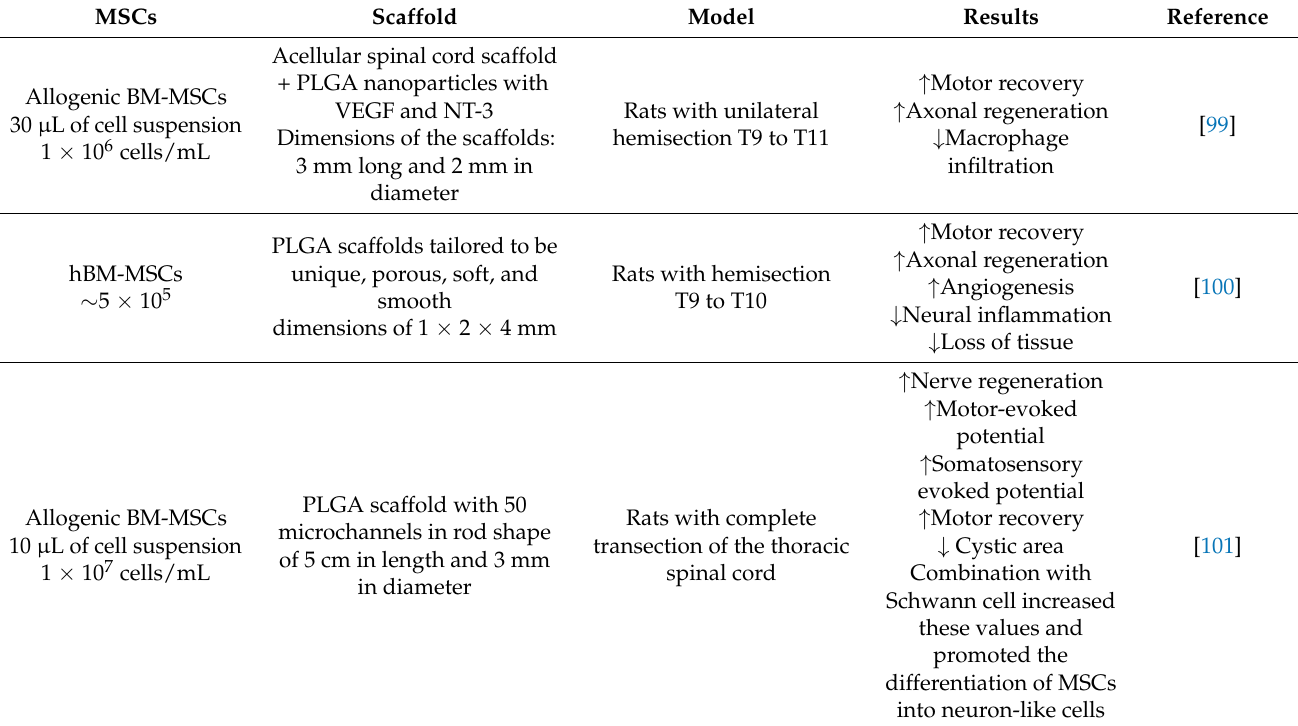
Table 4. Overview of the studies evaluating biochemical and cellular changes using MSC-enriched PLGA scaffolds in in vivo SCI